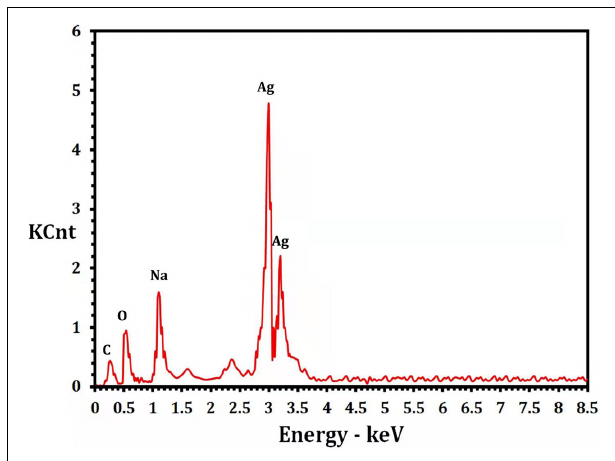
FIGURE 7 | Energy dispersive x-ray analysis of the Nocardiopsis dassonvillei M1-derived Bio-AgNPs.